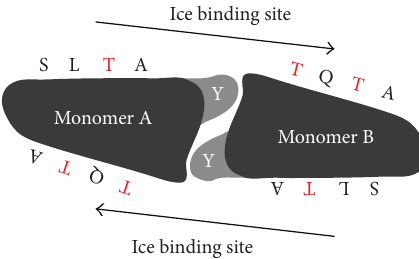
Figure 8: Schematic diagram of the dimerization of Pb INP using tyrosine ladders. Dimerization allows for tetrapeptides of each side of a monomer to create a relatively flat Thr-X-Thr based ice binding surface. Threonine residues used on the ice binding surface are highlighted in red. S: Ser, L: Leu, T: Thr, A: Ala, and Q: Gln. Adapted from Garnham et al.